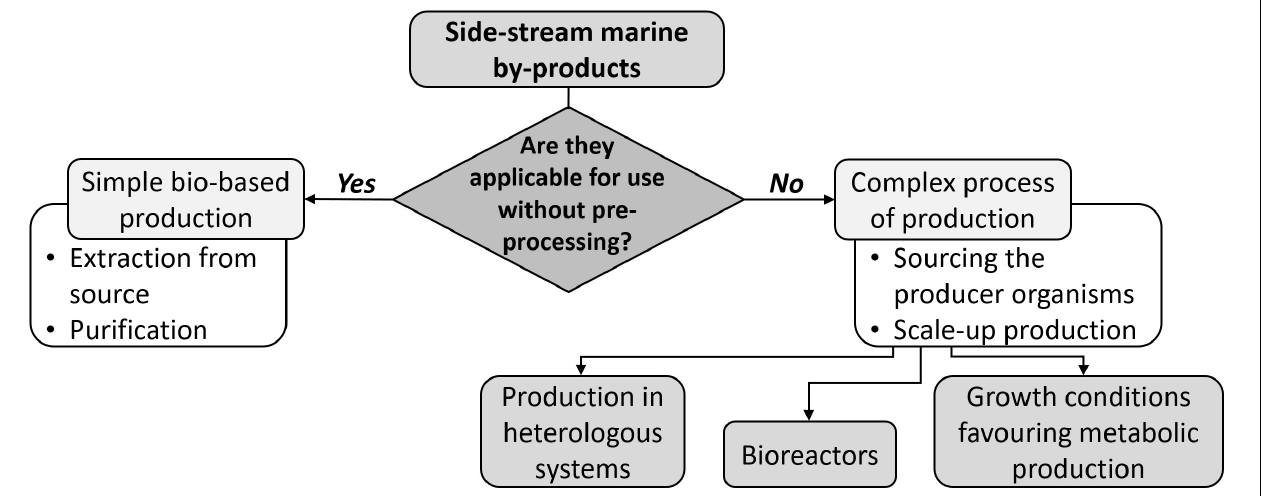
FIGURE 1 | The options for utilization of side-stream marine by-products: simple production or combination of bio-based production and growth of producer species or production in heterologous systems, guaranteeing a sustainable sourcing (in case of bio-based production) or a sustainable supply (in case of the complex process of production) of marine